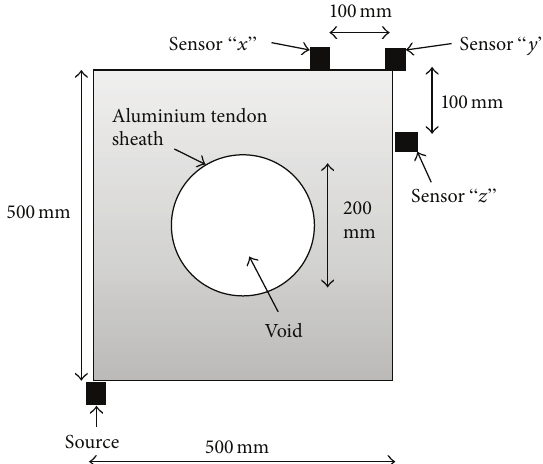
Figure 18: Illustration of location of sensors “ 𝑎 ”, “ 𝑥 ”, “ 𝑦 ”, and “ 𝑧 ”.